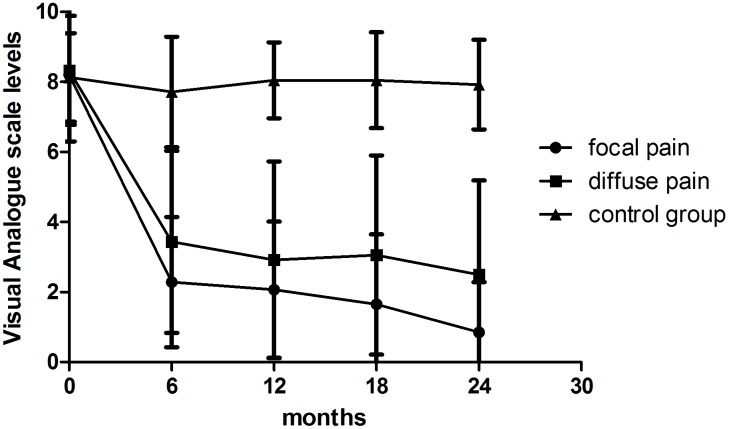
The figure displays the records of VAS levels at different time points.The VAS scores in both surgical groups showed notable decline with the time course while no changes occurred in control group during the follow-up. The overall postoperative VAS levels of focal pain group were much lower than that of diffuse pain group (P<0.01).